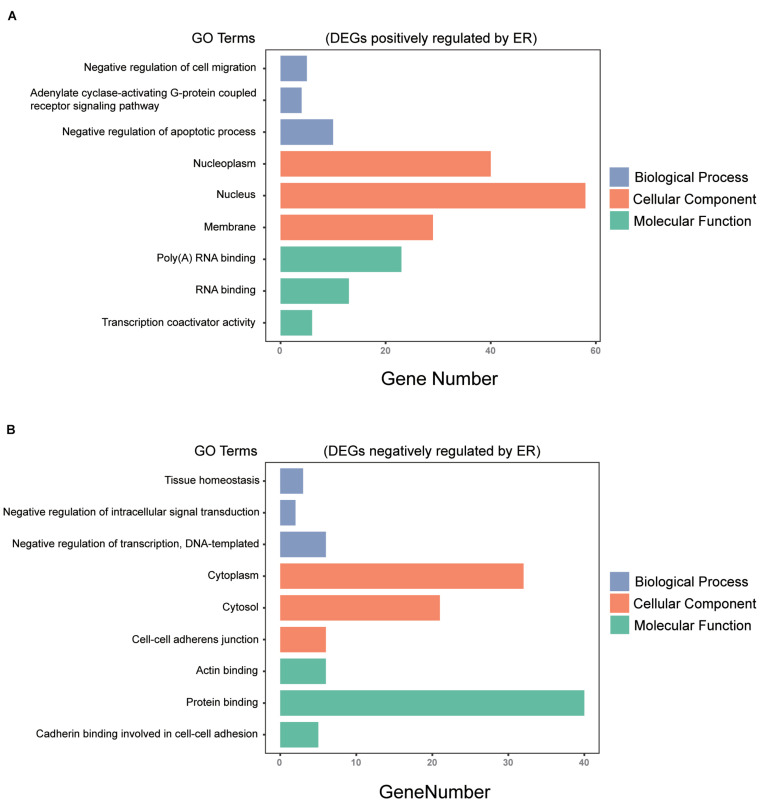
Gene ontology (GO) analysis of the common DEGs among the three breast cancer datasets. (A) DEGs positively regulated by ER were analyzed by GO enrichment, the top 3 in P-value ranking (sorting from small to large) in biological process (BP), cellular component (CC), and molecular function (MF). (B) DEGs negatively regulated by ER were analyzed by GO enrichment, the top 3 in P-value ranking (sorting from small to large) in BP, CC, and MF (P < 0.05).